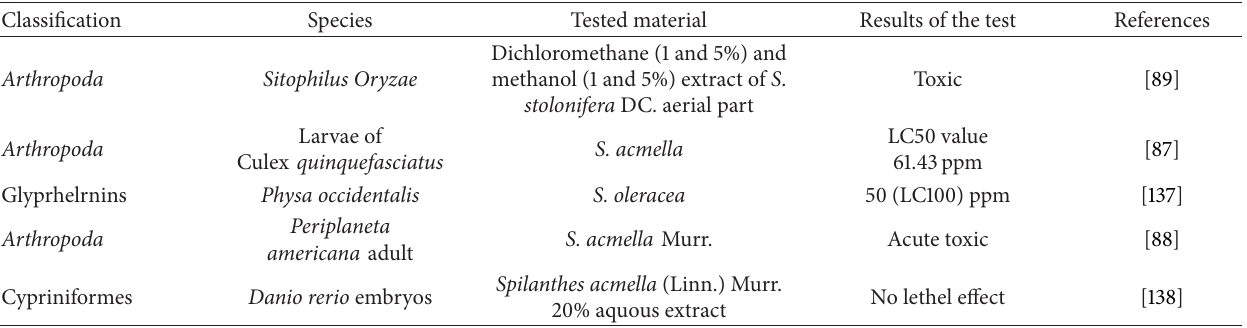
Table 5: Insecticidal activities of extracts of Spilanthes